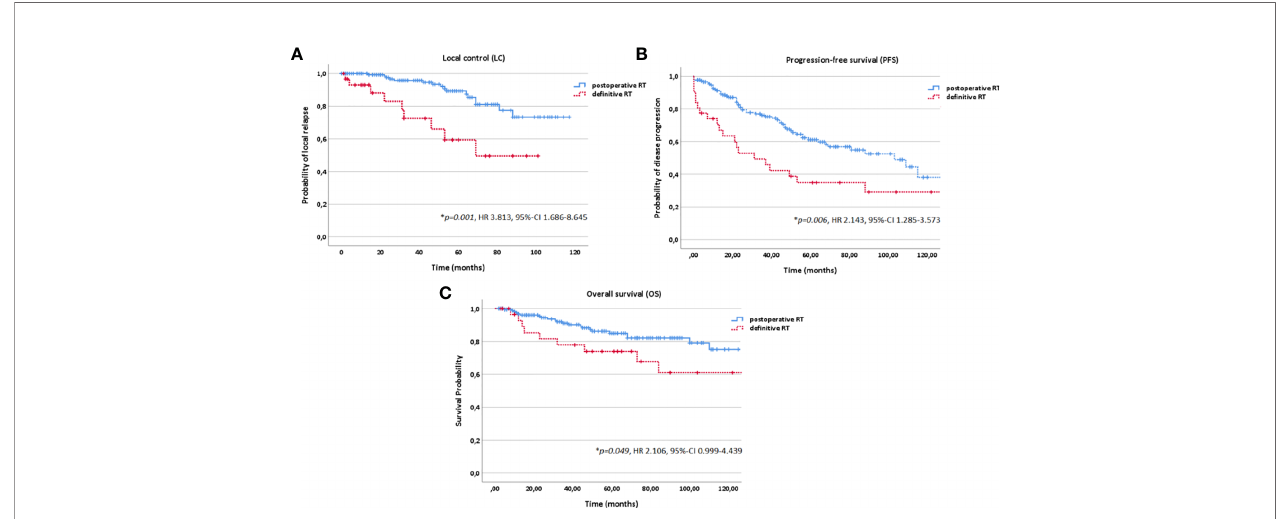
FIGURE 4 | Kaplan-Meier estimates for local control (A) , progression-free survival (B) and overall survival (C) in dependence of the treatment modality (postoperative vs. de fi nitive RT).